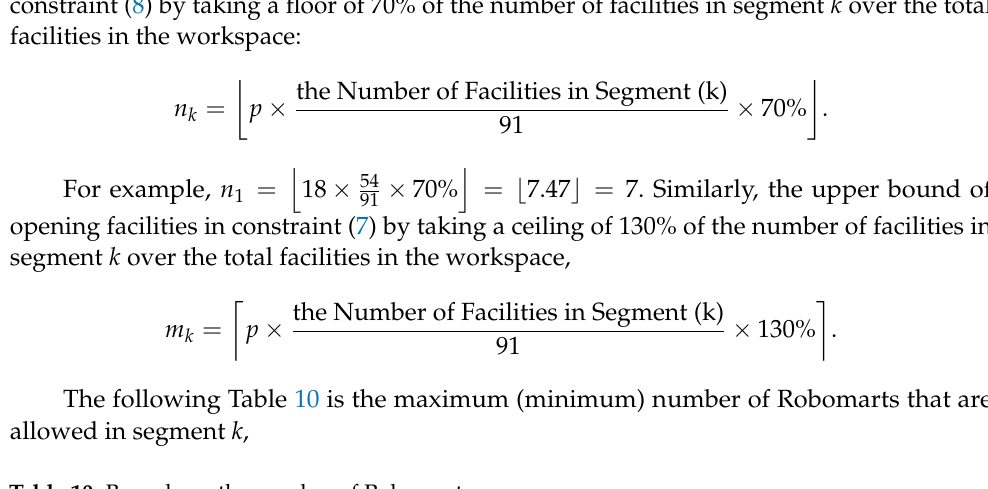
Table 10. Bounds on the number of